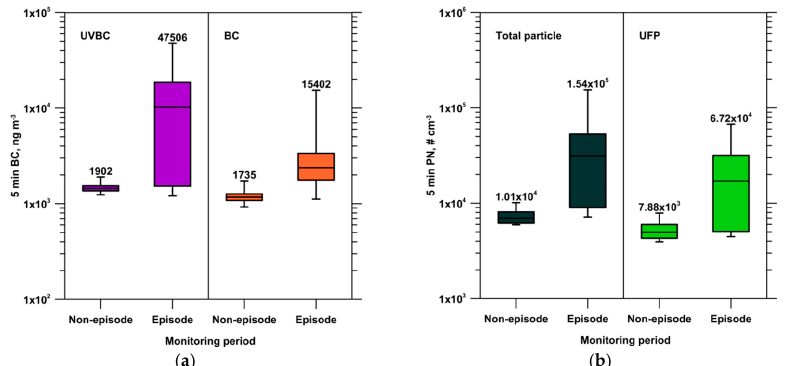
Figure 9. Five-minute concentration levels of ( a ) UVBC and BC; and ( b ) total particle and UFP during the non-episode and episode periods. The box and whisker plot show the lowest, lower quartile, median, upper quartile, and maximum values.